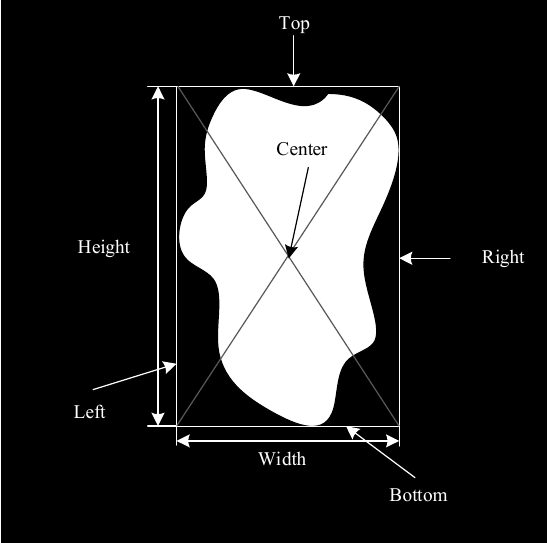
Fig. 4 Descriptive parameters of the